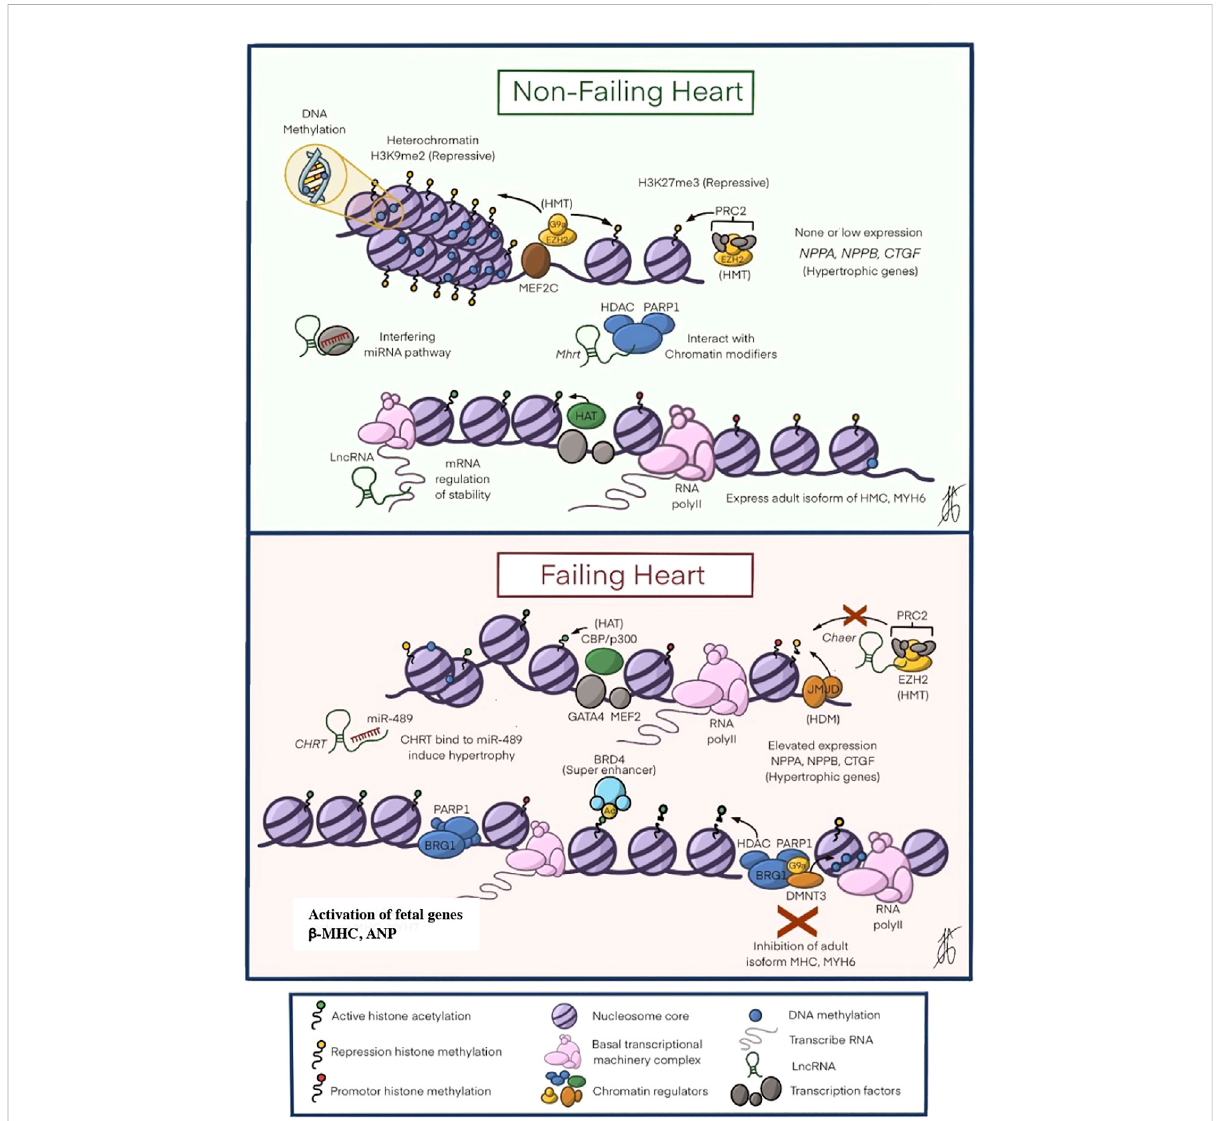
FIGURE 2 The Epigenetic Mechanisms in Heart Failure. In A shows the perfect balance between the different epigenetic modi fi cations to ensure that the heart develops appropriately. As seen in the fi gure, there is a greater expression of restrictive modi fi cations: DNA methylation, histone modi fi cation (H3K9me2 and H3k27me3), and interaction of non-coding RNA that causes chromatin modi fi cations to modulate down the expression of NPPA, NPPB and CTGF genes related to cardiac hypertrophy. In B shows how the balance above is altered, with a decrease in DNA methylation, an increase in histone acetyltransferases (HAT), PRC2 alterations that prevent histone methylation, as well as the expression of HDACs that lead to the inhibitionofessentialgenesforthecytoskeletonsuchasMHCandMYH6.AllthesechangesincreasetheexpressionofthehypertrophicgenesNPPA, NPPB, and CTGF, leading to the development of hypertrophic cardiomyopathy. ATP, adenosine triphosphate; CpG, cytosine-phosphate-guanine; HAT, histone acetyltransferase; HDAC, histone deacetylase; HMT, histone methyltransferase; mRNA messenger RNA; BRD4,